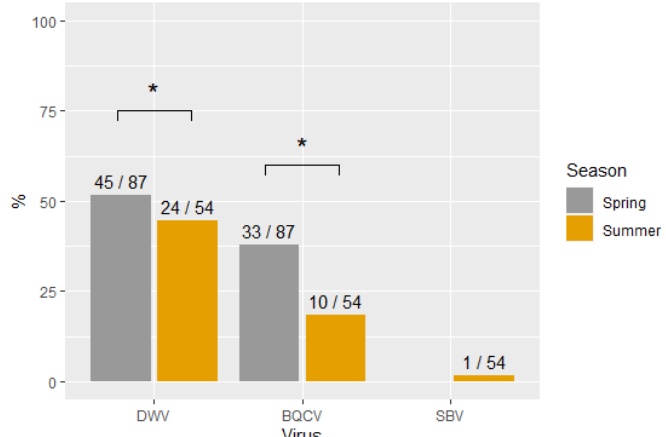
Figure 1. Percentage of virus infections in each sampling season. Significant differences are indicated with *. The numbers on top of each bar represent the number of positive samples and the total sample for each group. Table 1. Virus prevalence in pooled egg samples from each participating country for both naturally surviving colonies (NSCs) and traditionally managed colonies (TMCs).